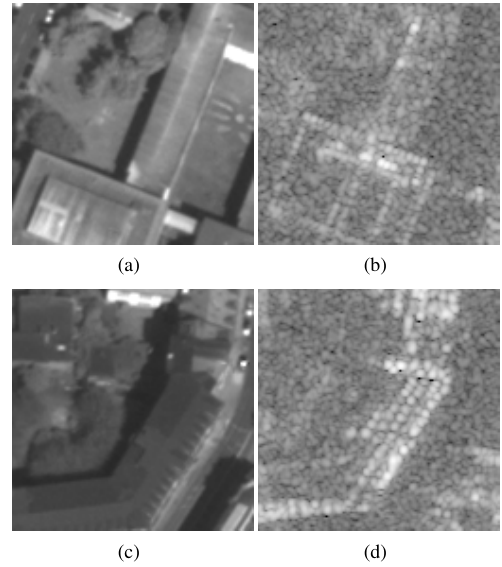
Figure 1: An example of corresponding SAR and optical patch pairs. Matching the image pairs in ( a , b ) and ( c , d ) proves to be a challenging task, even for domain